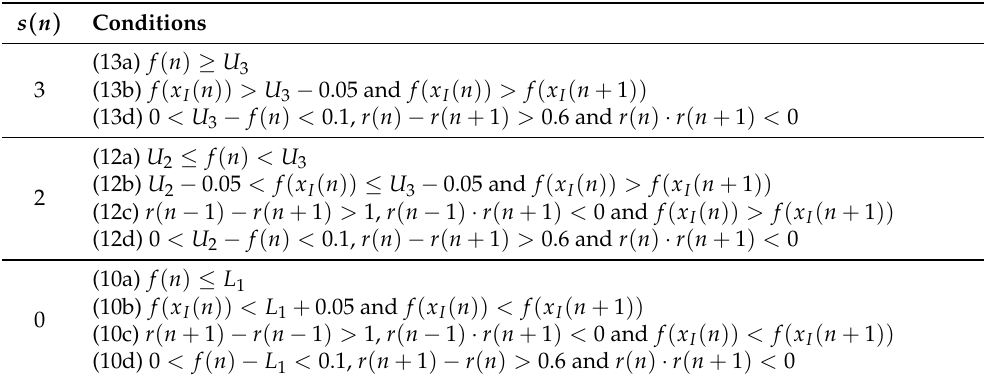
Table 5. Conditions for status change with s ( n − 1 ) =